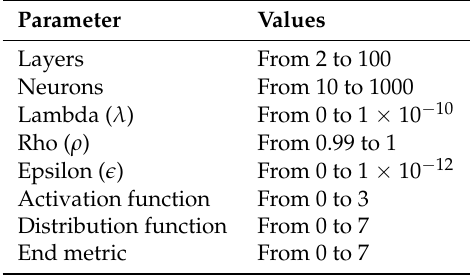
Table 2. Search space of the neural network